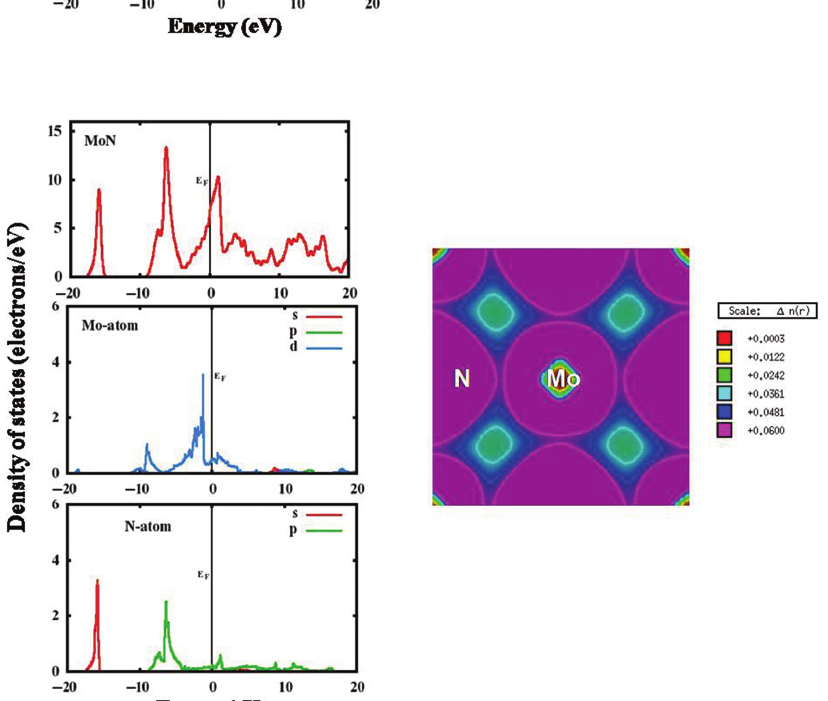
Figure 9: Electronic DOS and 2D charge density of CrN.